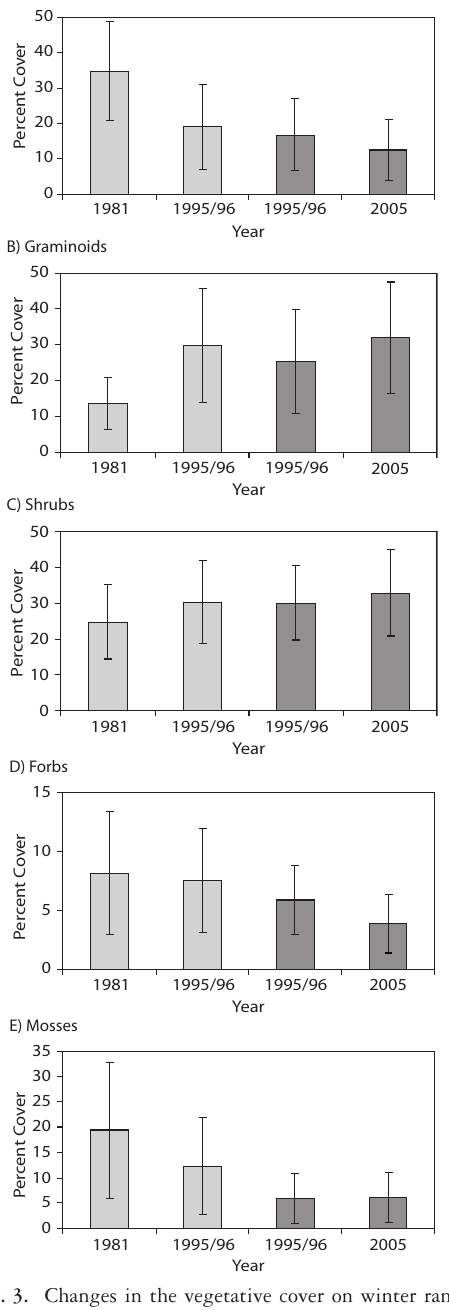
Fig. 3. Changes in the vegetative cover on winter range transects in the Buckland Valley, Seward Peninsula, Alaska from 1981 – 2005 for various categories. Ocular estimation techniques were employed during 1981 and 1995/96 (light gray bars), but a point intercept method was used in 1995/96 and 2005 (dark gray bars). Figure depicts mean ±